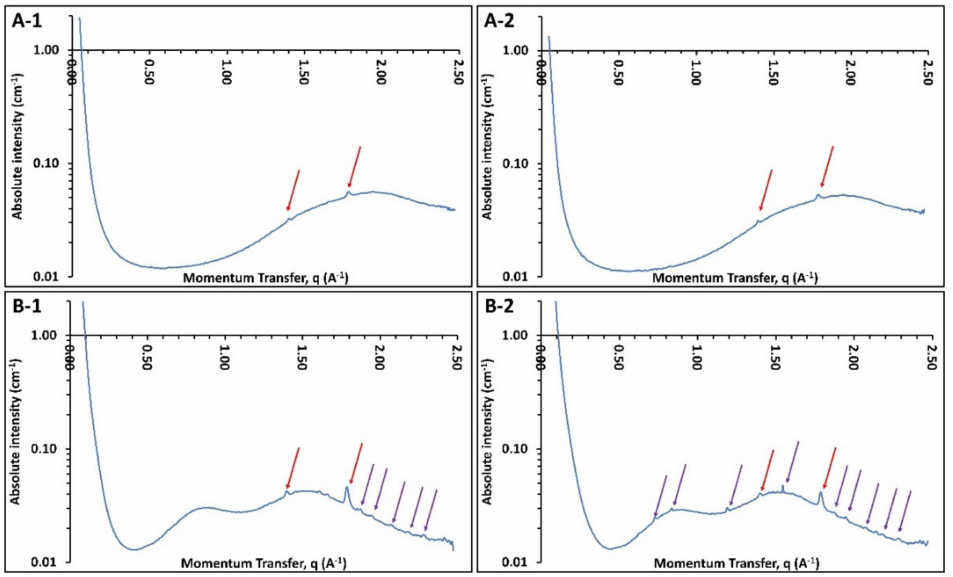
Figure 10. Wide-angle X-ray diffraction of samples withdrawn from the dissolution vessels, ( A-1 ) 100 mm/s PFS at pH 2, ( A-2 ) 100 mm/s PFS at pH 6.8, ( B-1 ) 100 mm/s UFS at pH 2, ( B-2 ) 100 mm/s UFS at pH